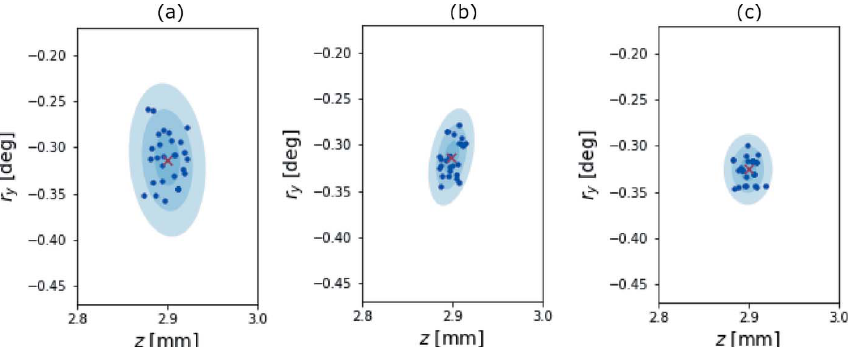
Figure 8 Depicted are the spatial results of three Monte Carlo simulations, in two of the four total dimensions. We included the simulated beam jitter, and fix the additive noise parameter & = 5.0 (cid:5) 10 (cid:3) 3 , varying the reflection parameter within Algorithm A.1. Panel ( a ) shows our default choice, (cid:4) = 1.0, panels ( b ) and ( c ) decrease the parameter to (cid:4) = 0.75 and 0.5, respectively. The results are depicted as blue scatter points above three confidence regions, and a red cross depicting the mean